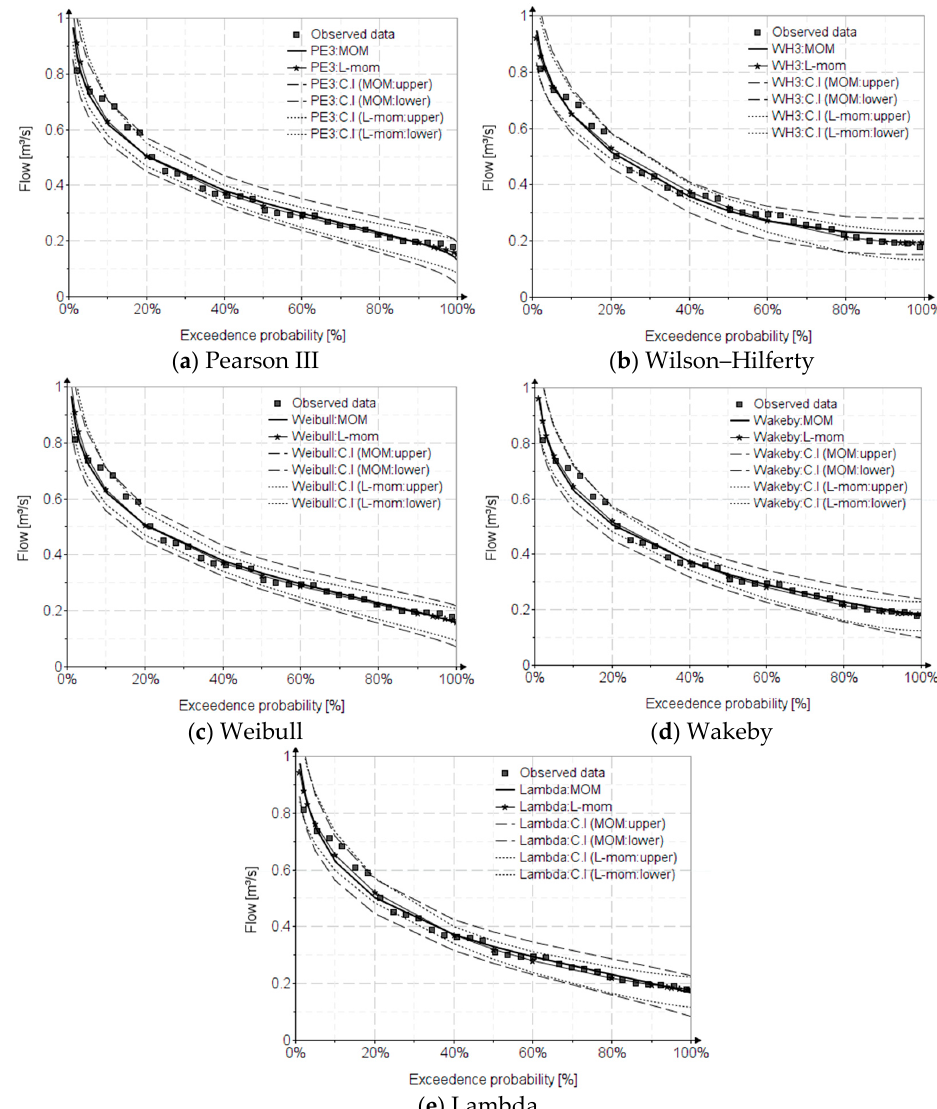
Figure 7. The probability distribution curves for minimum 7 ‐ day low flows.